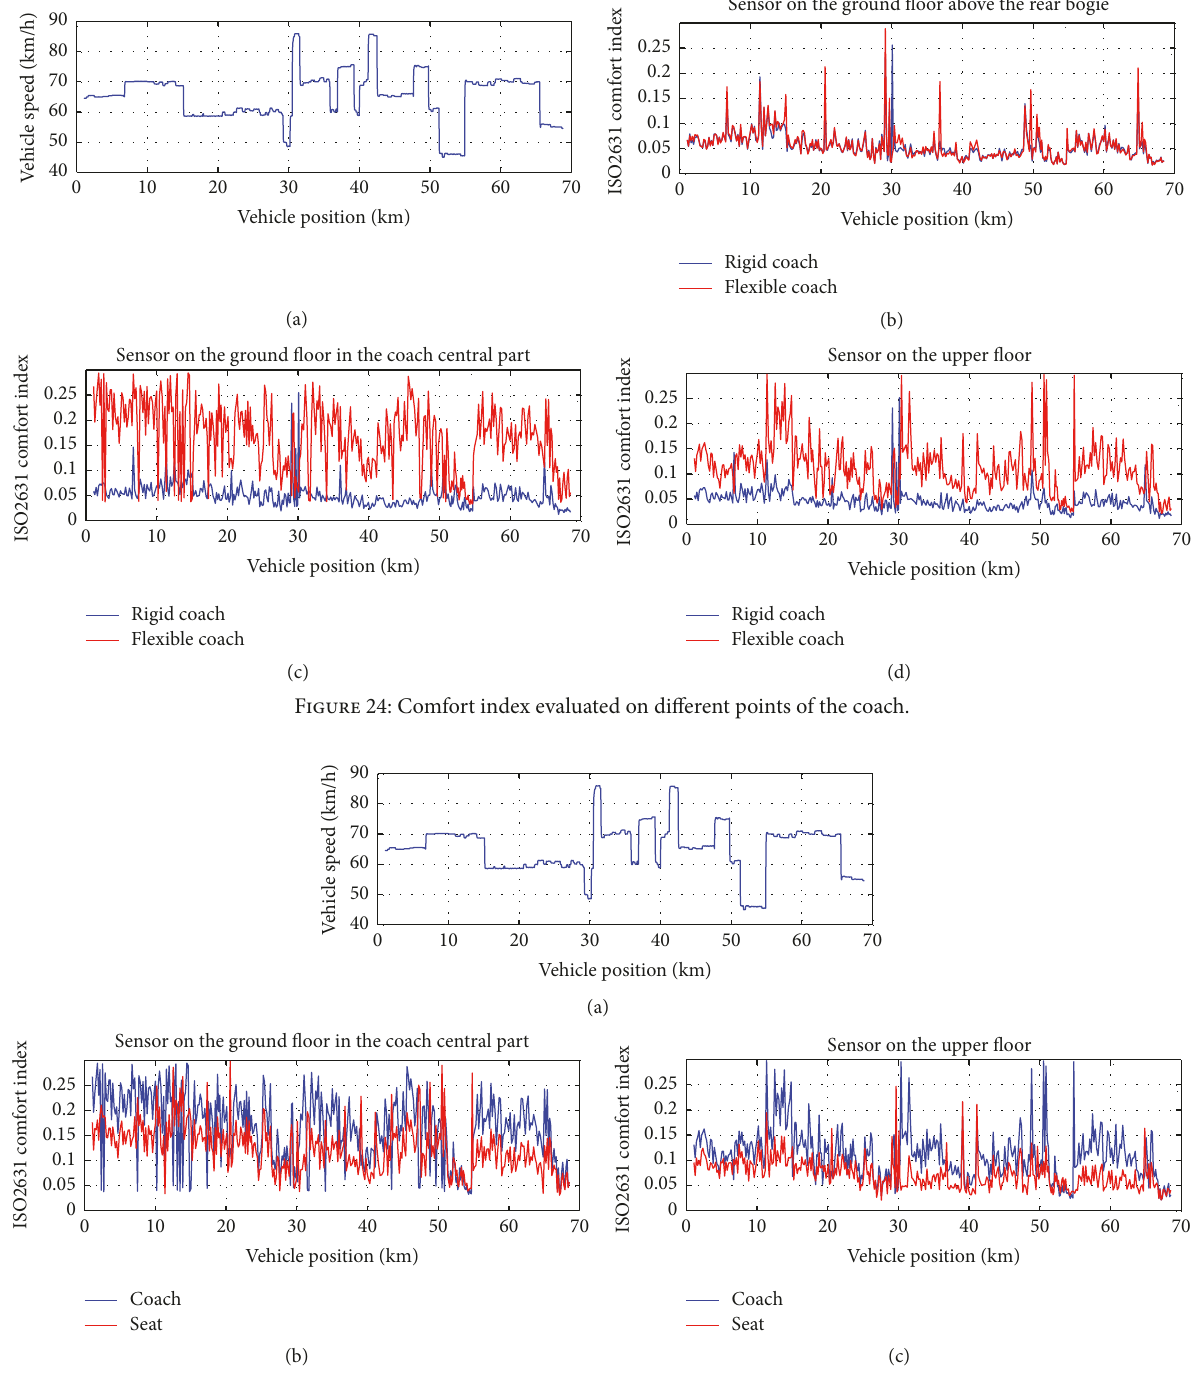
Figure 25: Comparison of the comfort index calculated on the coach and on the seat, on the ground floor (b), and on the upper floor